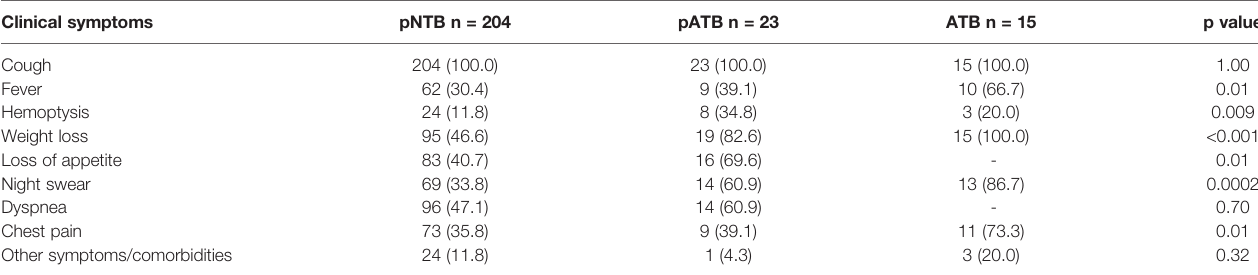
TABLE 2 | Description of presumptive TB clinical symptoms of the study participants.